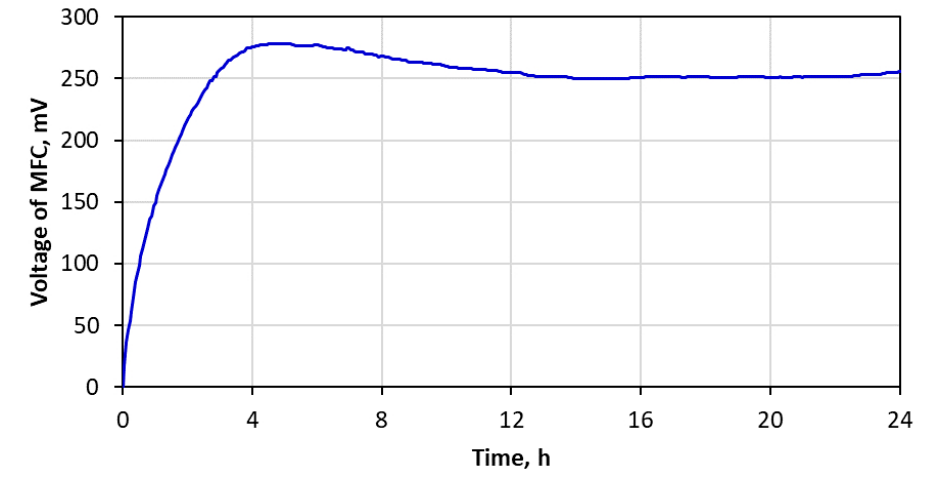
Figure 3. Variation of open circuit voltage of microbial fuel cell (MFC) over time at ambient temper- ature.